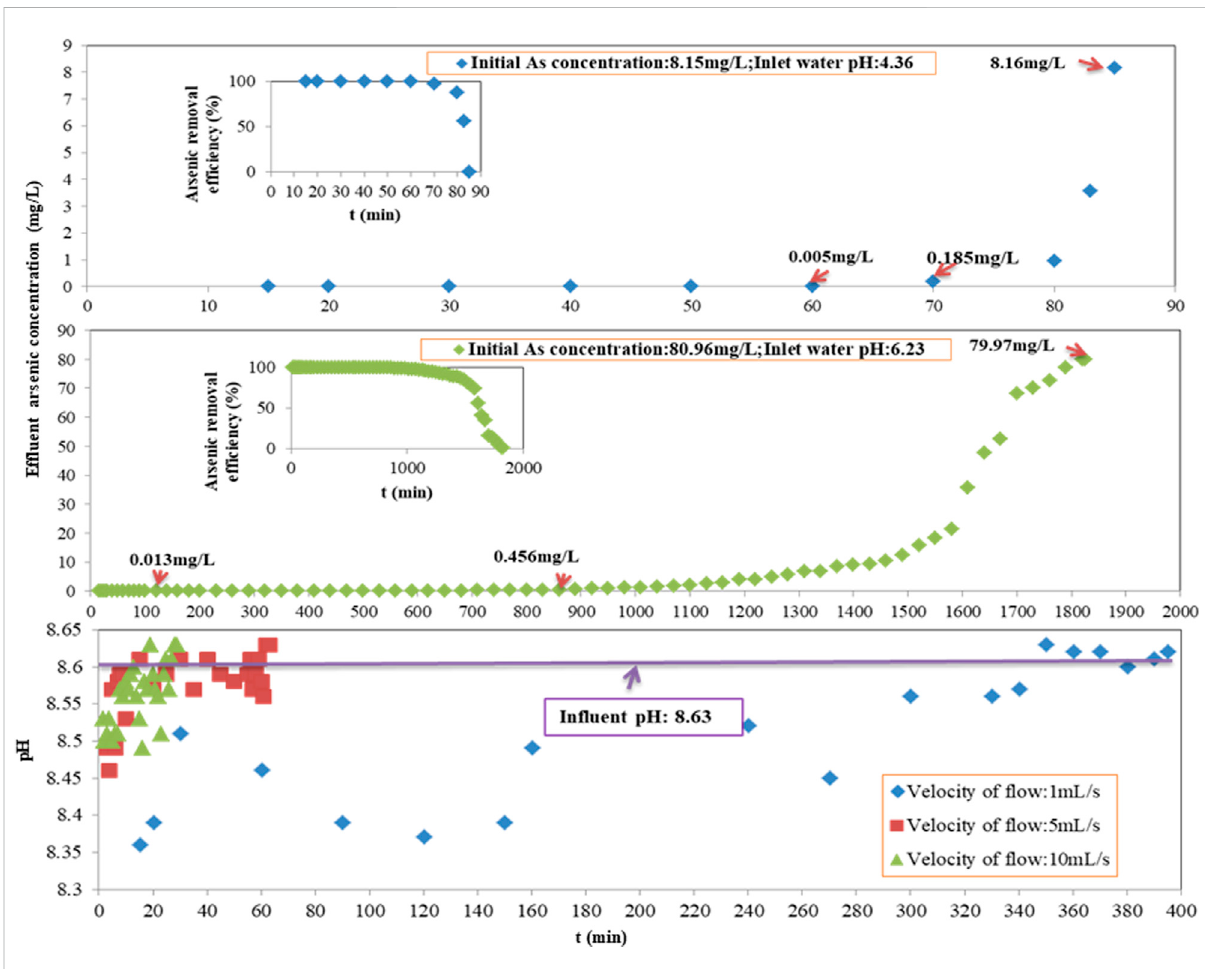
FIGURE 3 Performance evaluation of Fe-PE for arsenic removal at an initial arsenic concentration of 8.15 mg/L with pH = 4.36 and 80.96 mg/L with pH = 6.23; and the ef fl uent pH of the adsorption column with time at different velocities of the fl